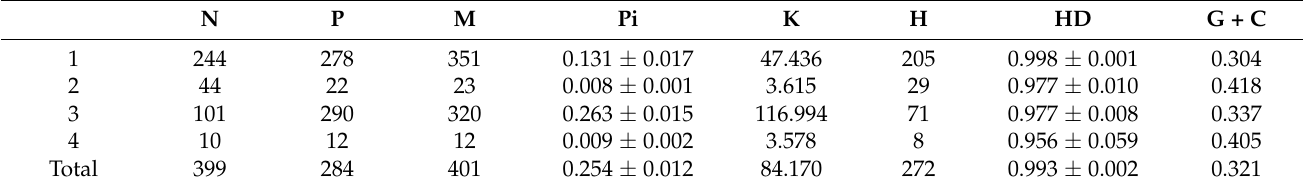
Table 1. A summary of polymorphic indices of African sheep